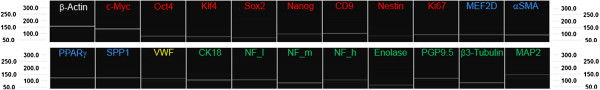
Expression analysis of gene transcripts from mammary gland-derived cell populations. Representative visualization of the capillary gel electrophoretic analyses of detected amplicons in the propagated female mammary gland-derived cells (MGDC 1) from passage 9. Expression of transcripts for the housekeeping gene β-actin (white), typical transcripts for stemness and proliferation (red) as well as for the mesodermal lineage (blue), the endodermal lineage (yellow) and the ectodermal lineage (green) could be verified.